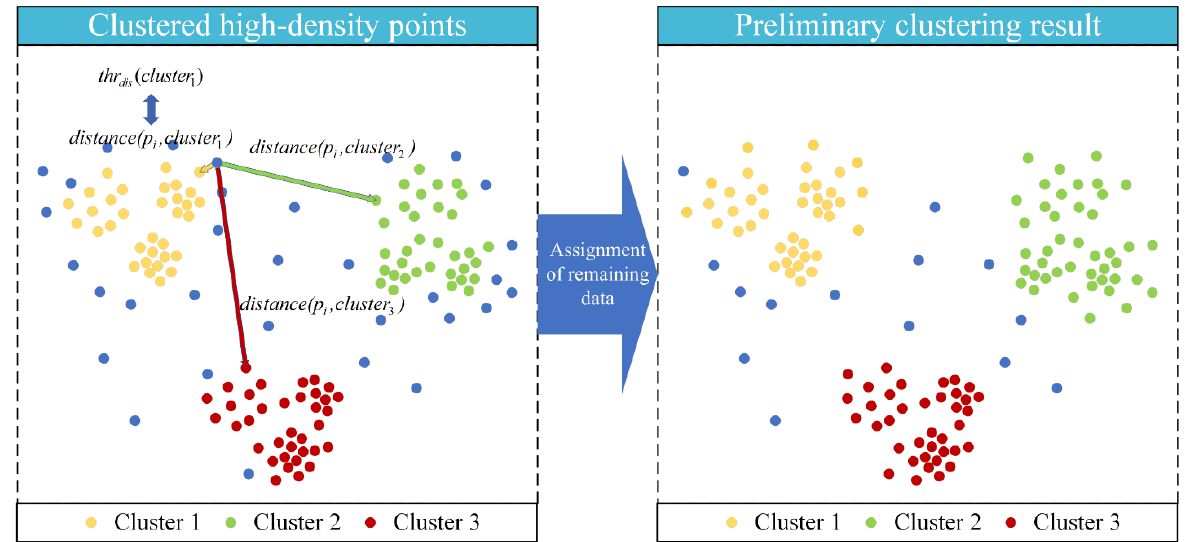
(Algorithm 2 line 7 – 9). In the example, distances between the selected point and three clusters are calculated. The smaller the distance, the greater the possibility. The process of p ) is as follows: a point ( i